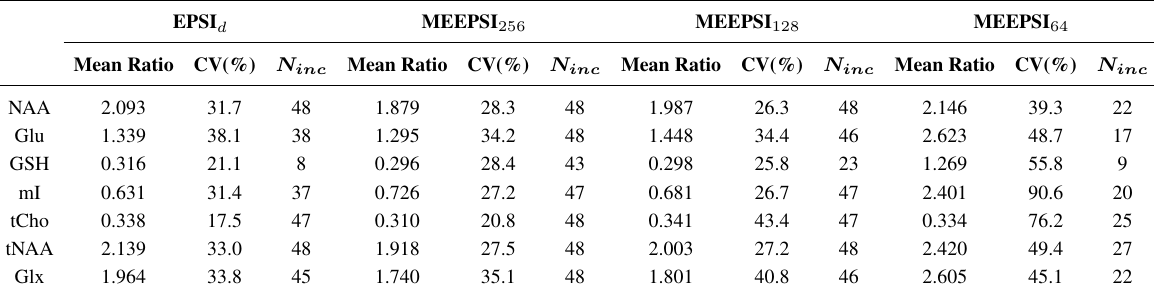
Table 3. Summary of the LCModel fit results for select metabolites for the different sequences. The central 6 × 8 voxel excited volume were processed. Ratios are shown with respect to Cr. N is the number of voxels in which LCModel reported a CRLB < 20 %. inc Only those voxels were included in the computation of mean ratios and coefficients